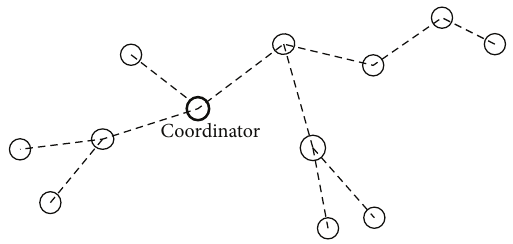
Figure 1: Selecting coordinator coalitional game